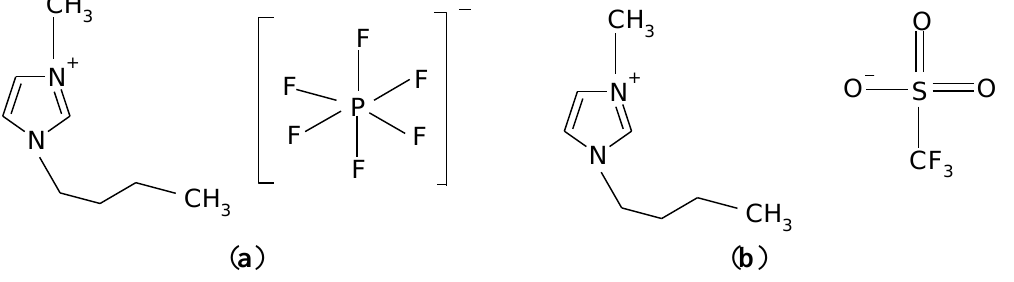
Figure 2. Structures of ( a ) 1-butyl-3-methylimidazolium hexafluorophosphate (BmImPF and ( b ) 1-butyl-3-methylimidazolium trifluoromethanesulfonate (BmImTf).